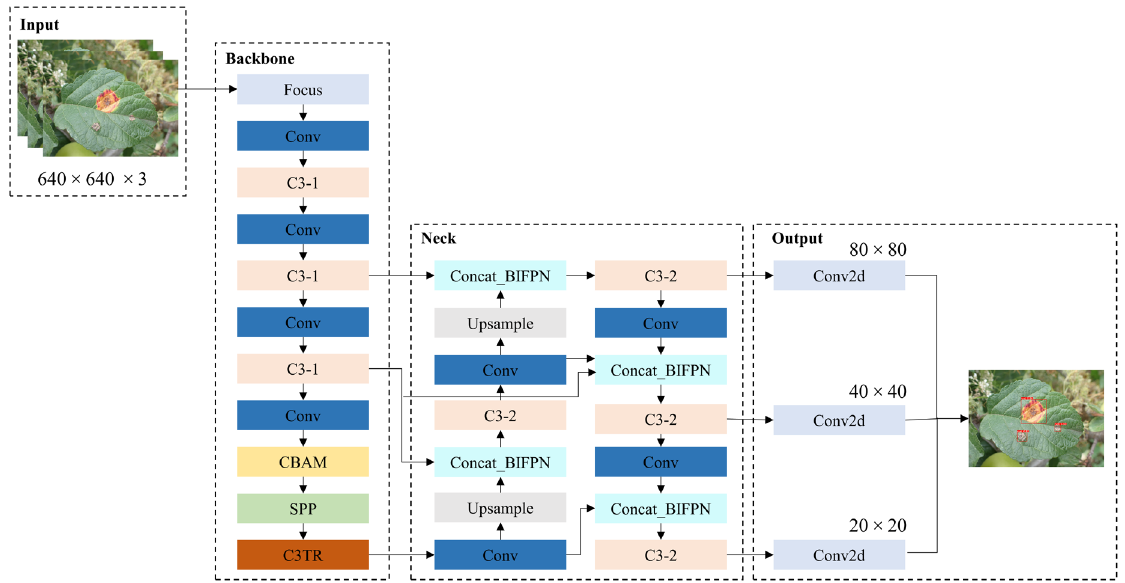
Figure 8. BTC-YOLOv5s model structure diagram.